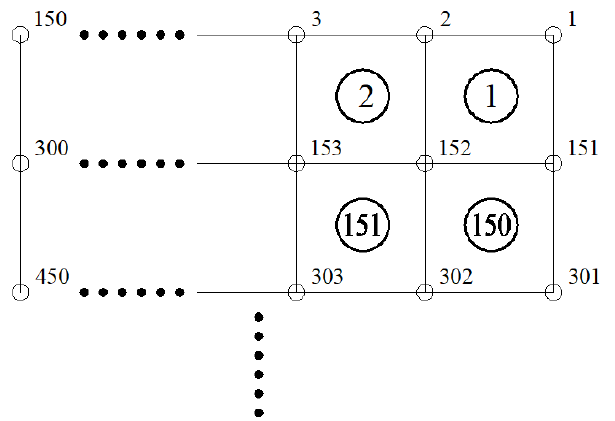
Figure 7. Schematic diagram of node number and element number.